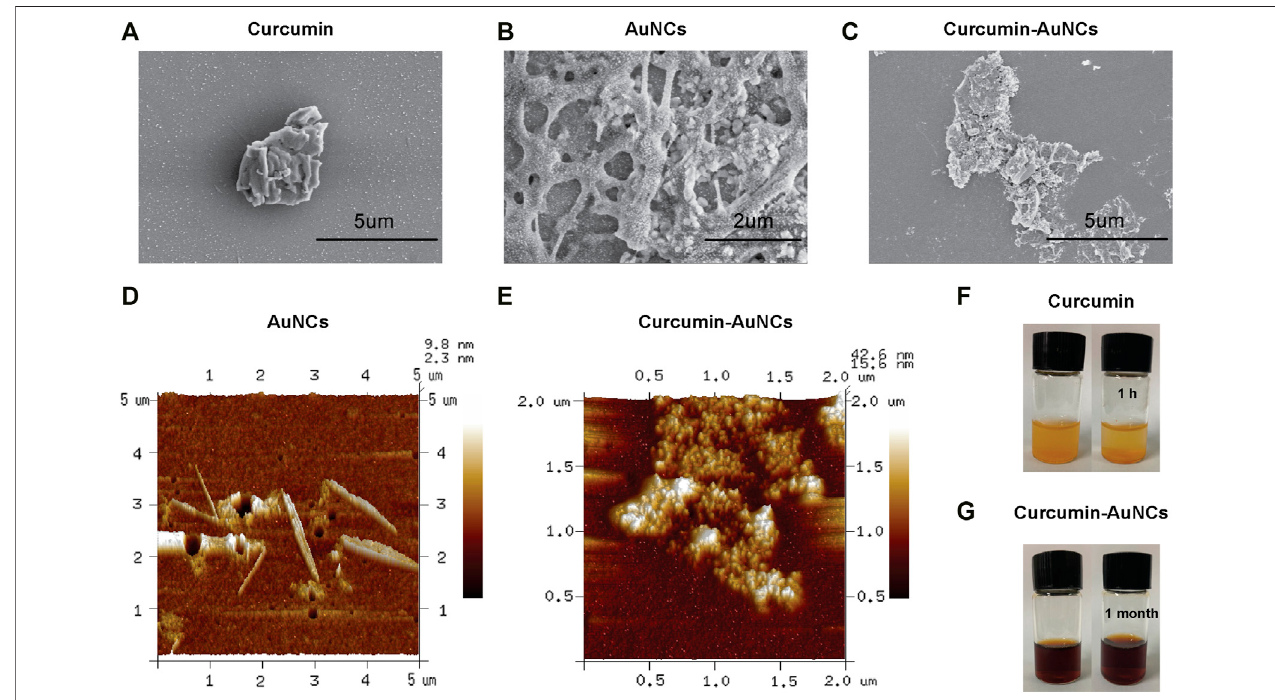
FIGURE 1 | SEM of Cur (A) , AuNCs (B) and AuCur (C) . AFM of AuNCs (D) and AuCur (E) . Cur (F) and AuCur (G) in water from the beginning to 1 h. Au indicates AuNCs.